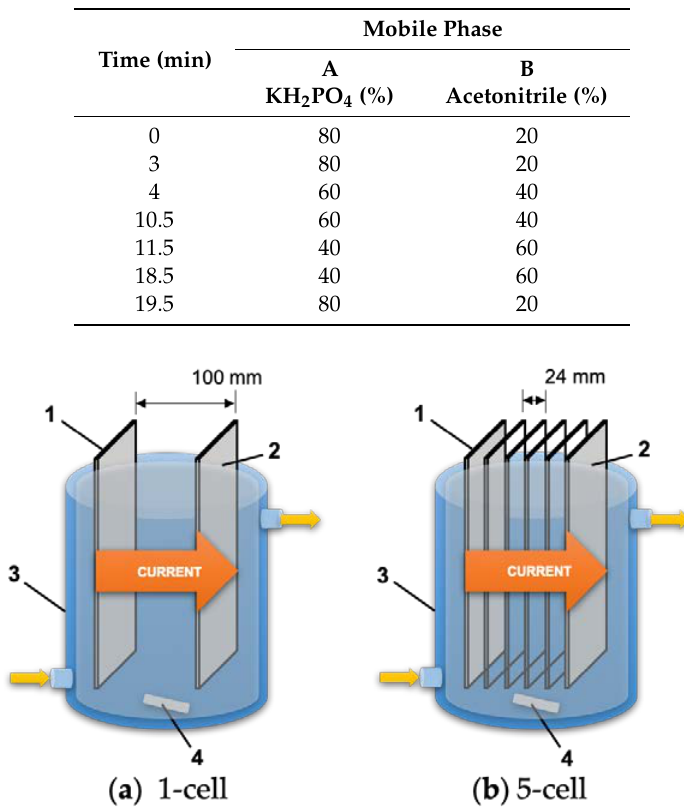
Figure 1. Profile of the batch reactor: ( a ) 1 cell and ( b ) 5 cell. 1: anode (aluminum, graphite). 2: cathode (aluminum, graphite). 3: Double layered cylindrical glass container ( ∀ = 1 L) with a water bath. 4: magnetic stirring bar.